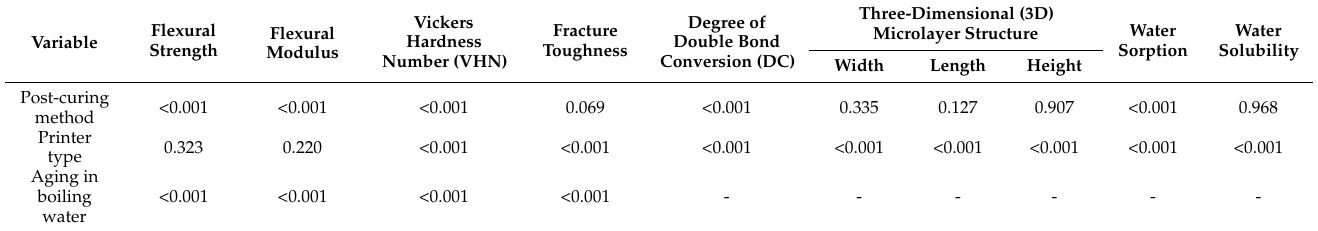
Table 1. p values of multiple-way ANOVA statistical analysis for the evaluated mechanical properties.